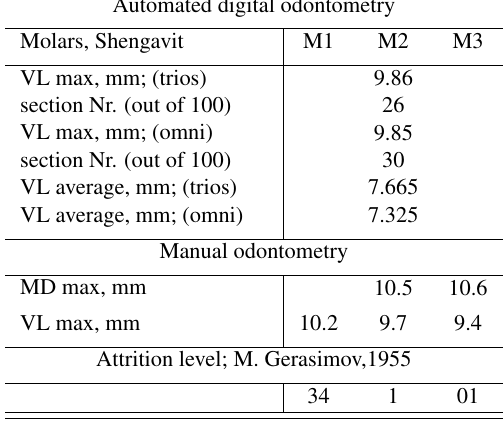
Table 1. Absolute dimensions and attrition level of molars, Shengavit